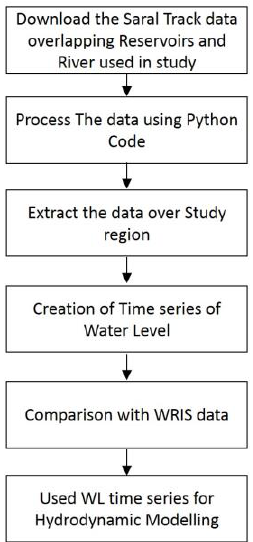
Figure 3. Methodology flowchart for Inland waterbodies water level and river discharge estimation